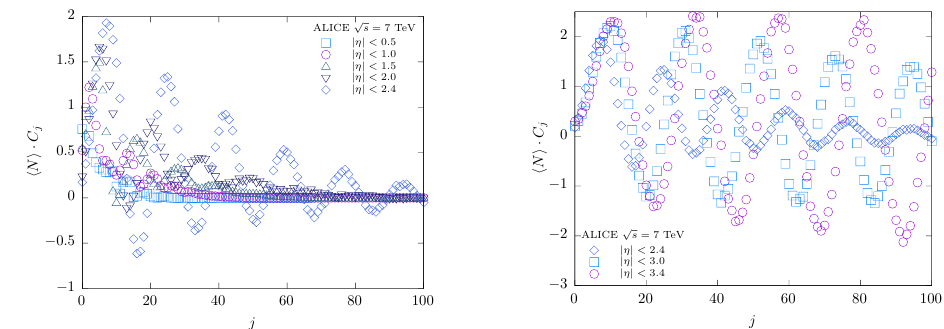
Figure 1. Plot of C j derived from ALICE data. Left panel: The plot is made with MD data up to | η | < 2 . 4. The amplitude increases with wider pseudorapidity interval which decays with increasing j . Right panel: The plot made with data up to | η | < 3 . 4 shows that the amplitude decay stagnates at | η | < 3 . 0 and increases with increasing j at | η | < 3 .